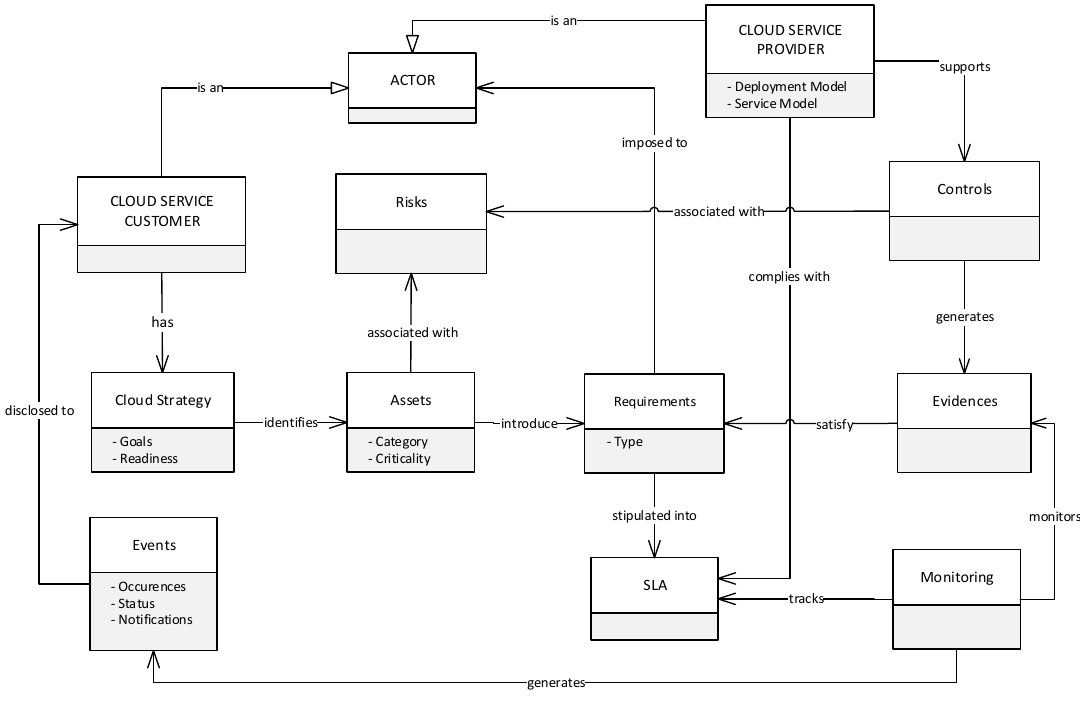
Figure 6. A metamodel for security transparency at the organisational level.